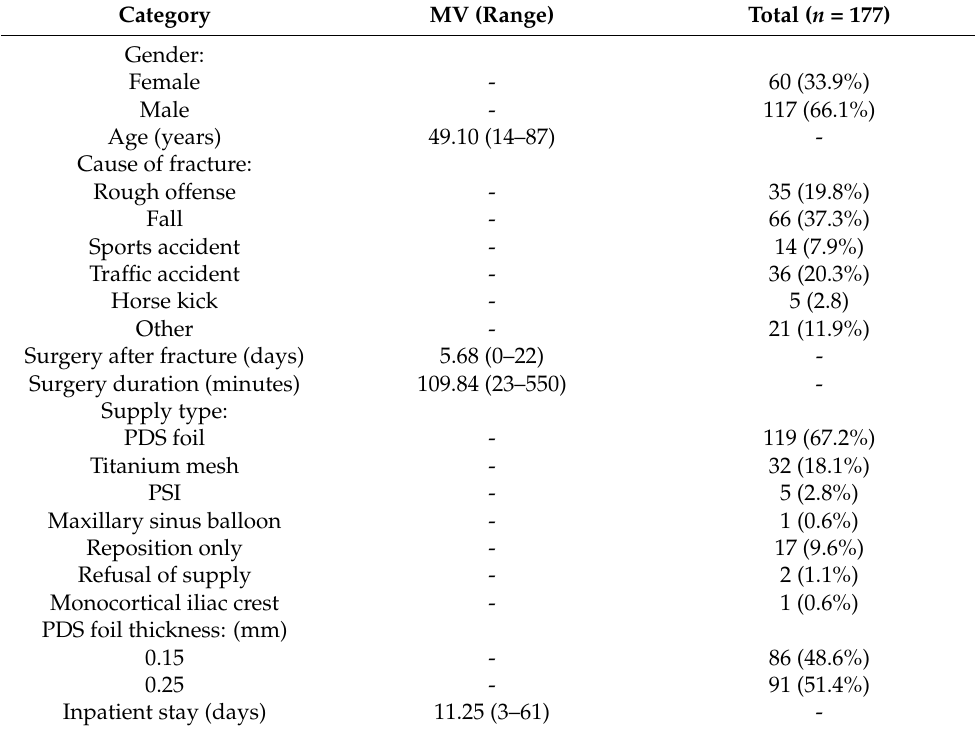
Table 1. Clinicopathological characteristics of the patient